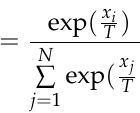
Figure 3. Intention classification framework based on knowledge distillation.